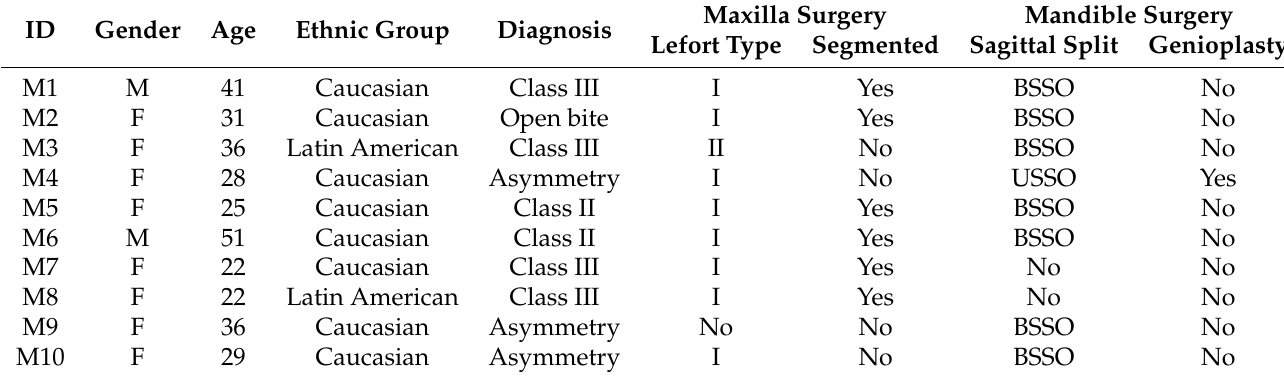
Table 1. Characteristics of the 10 patients analyzed in the study, including surgical procedures applied to maxilla and